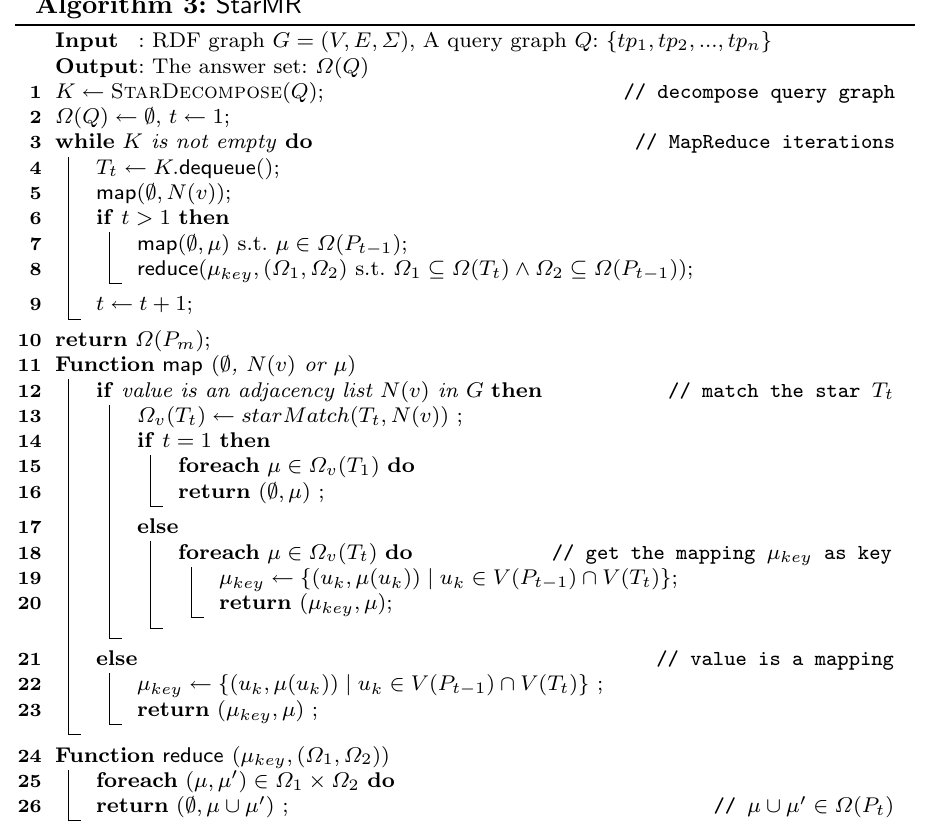
Algorithm 3 decomposes the query Q into a queue K of